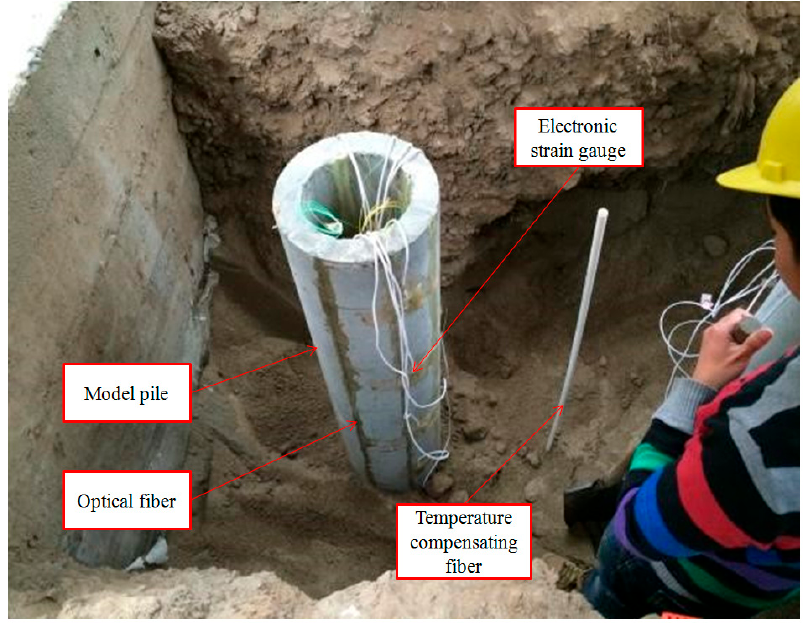
Figure 4. Burying the PCC pile.